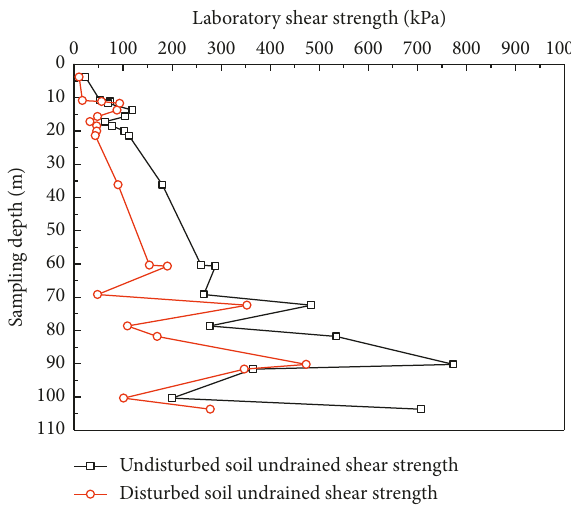
Figure 10: Laboratory shear strength values.